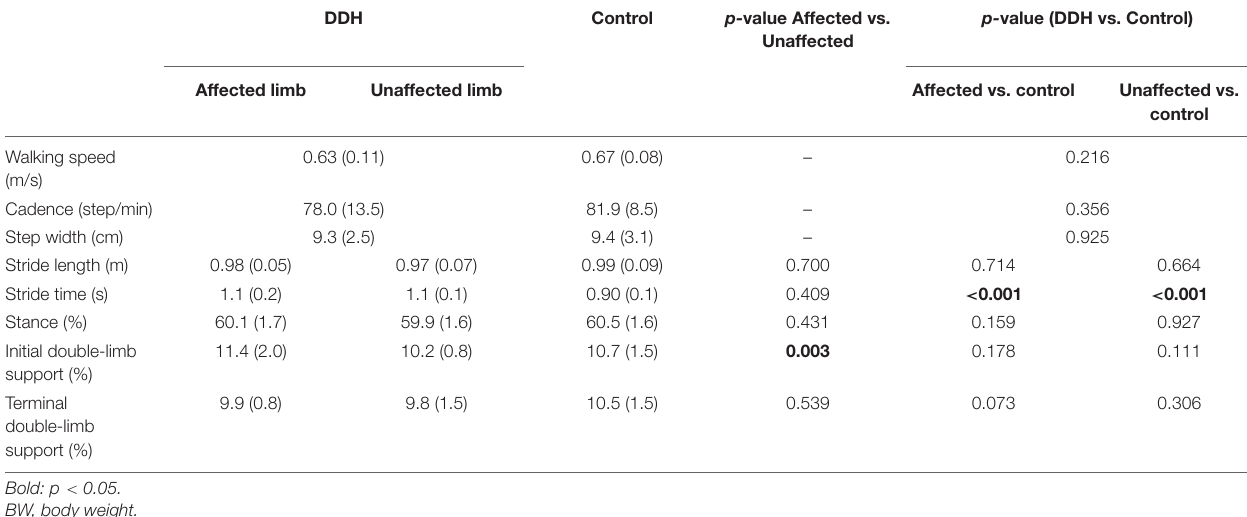
TABLE 3 | Means (standard deviations) of the peak loading and unloading rates of the joint axial forces and vertical ground reaction forces (GRF). DDH patients Healthy controls p- value Affected vs.